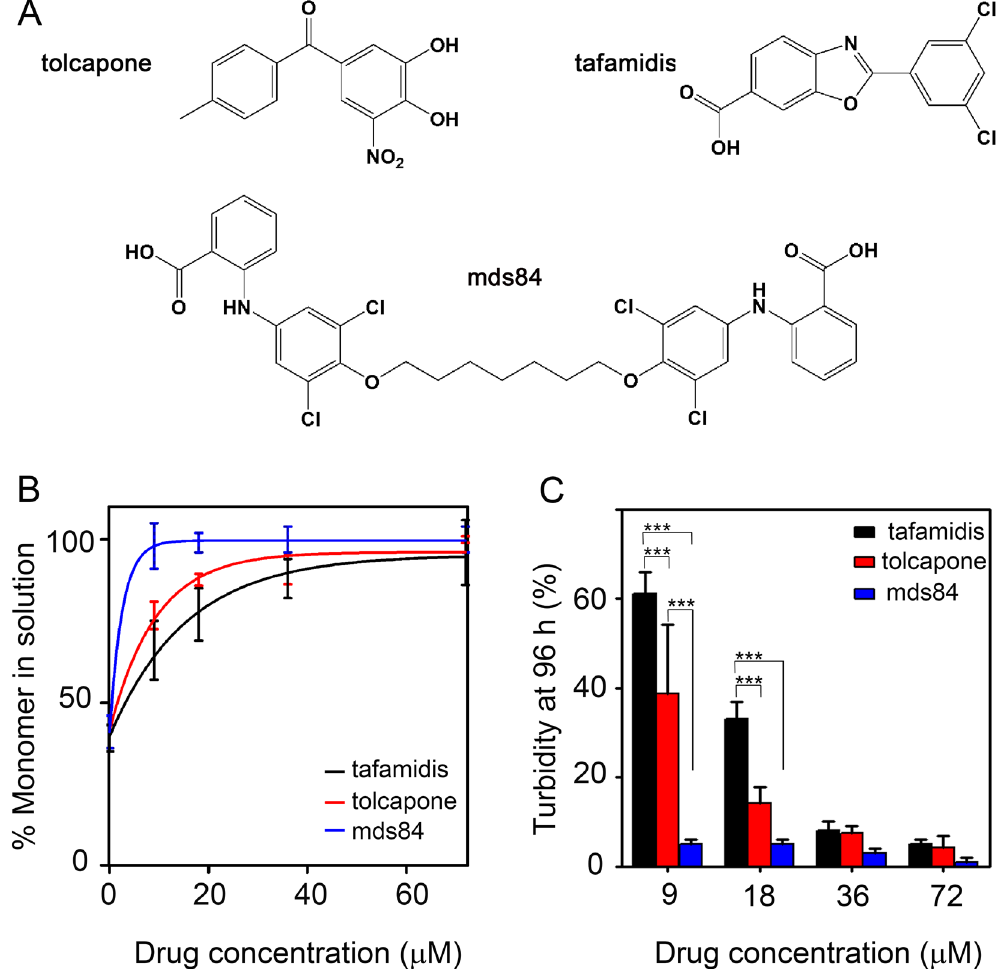
Figure 1. Comparative effect of tolcapone on proteolysis and fibrillogenesis of V122I TTR. ( A ) Chemical structures of tolcapone and tafamidis together with the TTR binding palindromic ligand, mds84. ( B ) Aggregation of 18 µ M V122I TTR in the presence of 0, 9, 18, 36 and 72 µ M of tolcapone, tafamidis and mds84 respectively in PBS pH 7.4 at 37 °C with fluid agitation was carried out after addition of trypsin at an enzyme:substrate ratio of 1:200. Selective proteolytic cleavage was monitored at 96 h by SDS-PAGE under reducing conditions (Supplementary Fig. S1). Intensities of the electrophoretic bands corresponding to the intact protomer in the whole mixture were normalized to 100% for the same band of the protein before addition of trypsin. The solid lines represent the nonlinear fit to the experimental mean (SD) of three replicates using GraphPad Prism v5. Two way ANOVA gave a P value < 0.001 for tafamidis vs mds84 at 9 and 18 µ M; for tolcapone vs mds84 at 9 µ M. ( C ) Aggregation of 18 µ M V122I TTR was quantified as spectrophotometric turbidity at 400 nm normalized to 100% for aggregation of the protein in the absence of ligands. We know from previous work that TTR aggregation in this system is in the form of authentic amyloid fibrils 3, 4 . All data shown represent mean (SD) of three independent experiments, and *** represents P <